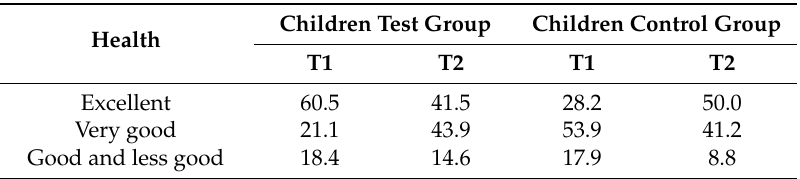
Table 1. Subjective health ratings (percentages) before moving in, at T1 (three months after moving in) and at T2 (one year later). Adults Test Group Adults Control Group Health Before Moving T1 T2 Before Moving T1 T2 Excellent 18.9 25.2 24.5 16.3 20.8 18.7 Very good 41.4 50.5 50.9 46.9 52.5 51.6 Good and less good 39.6 24.3 24.5 35.6 26.7 29.7